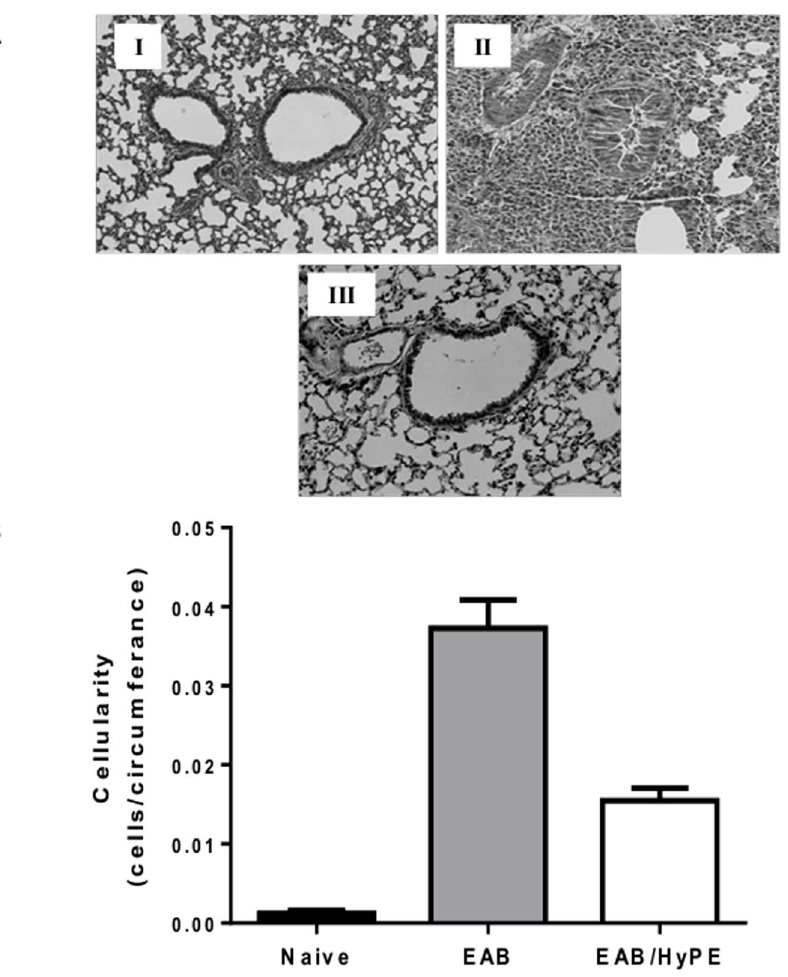
Figure 4. Lung histology of mice with OVA-induced EAB. A. Representative micrographs of lung histology: Mice lung tissues were stained with hematoxylin and eosin. I: Healthy mice II: Untreated EAB mice. III: EAB mice treated with HyPE. B. Peri-bronchial infiltration of inflammatory cells. The number of leukocytes in lung peri-bronchial space was determined by morphometry. Data are mean 6 SEM for 10 mice.*, # , P , 0.01.